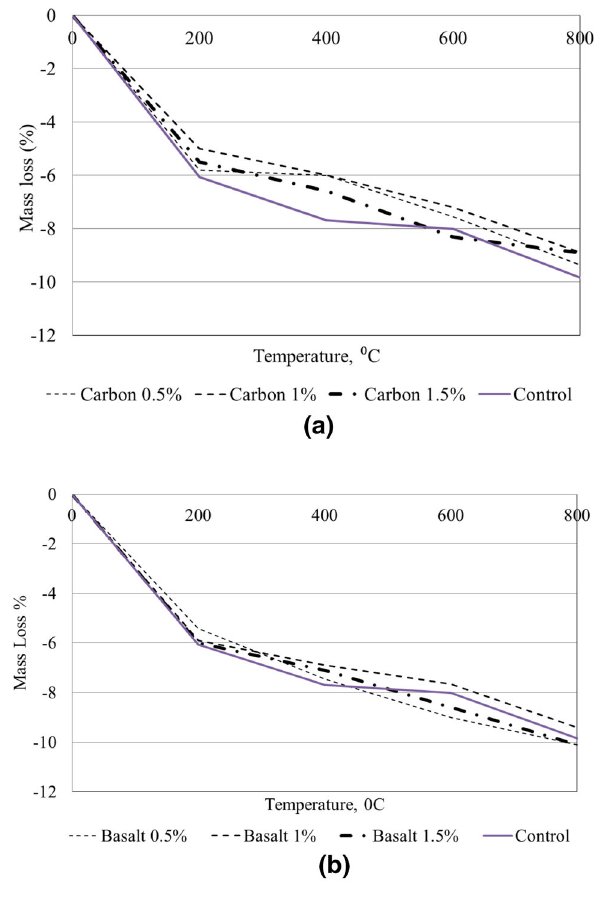
Fig. 4 Mass loss of carbon and basalt fibre reinforced fly ash geopolymer composites at various elevated tempera- tures. a Carbon fibre reinforced fly ash geopolymer composite and b Basalt fibre reinforced fly ash geopolymer